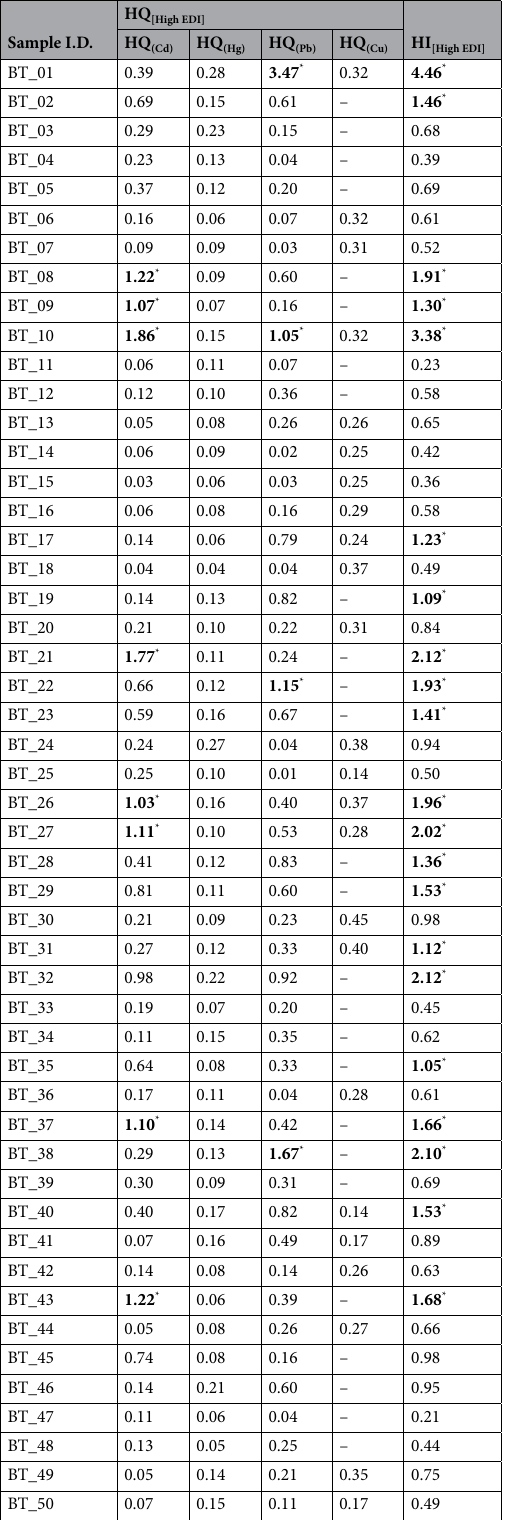
Table 7. Theoretical Hazard Quotient (HQ) and resulting Hazard Indices (HI) estimated for Cd, Hg, Pb, and Cu—representing the worst-case exposure scenario only (i.e. Short-term EDI @ 200 g day −1 consumption). Values highlighted in bold (*) represent exceedance of HQ and HI ≥ 1 (i.e., “potentially unsafe”). Values < 1 considered “no risk” or “safe”. HQ’s calculated at the lower EDI (@200 mg day −1 ) and both CDI’s consumers. These values are therefore excluded from this table (data not